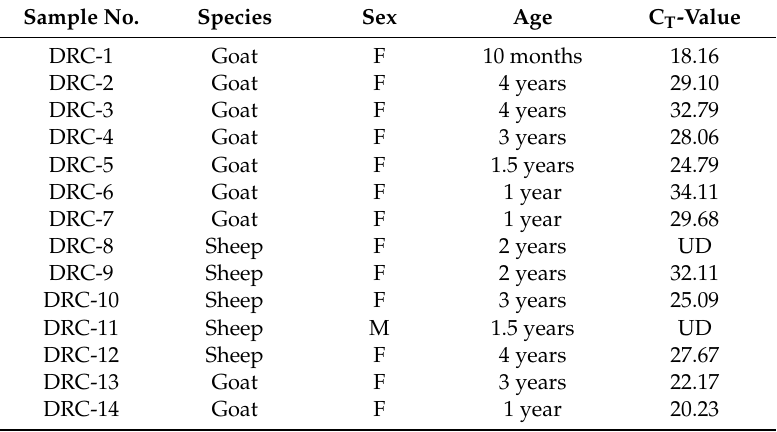
Figure 4. Percentage inhibition (PI) value distribution of peste des petits ruminants (PPR) N antigen-based competitive ELISA (IDVET, Montpellier, France) shown by species and locations sampled in Uganda and South Sudan. Wildlife from Uganda were sampled in Queen Elizabeth National Park and wildlife from South Sudan within the Nile basin and Boma National Park. Positive samples below the 50% percentage of inhibition are shown in the graphs with a black dashed line. Table 3. Information of the nasal swab samples collected on 20 October 2017 from small domestic ruminants in Democratic Republic of the Congo and respective C T -values (cycle-threshold values) obtained in the RT-qPCR